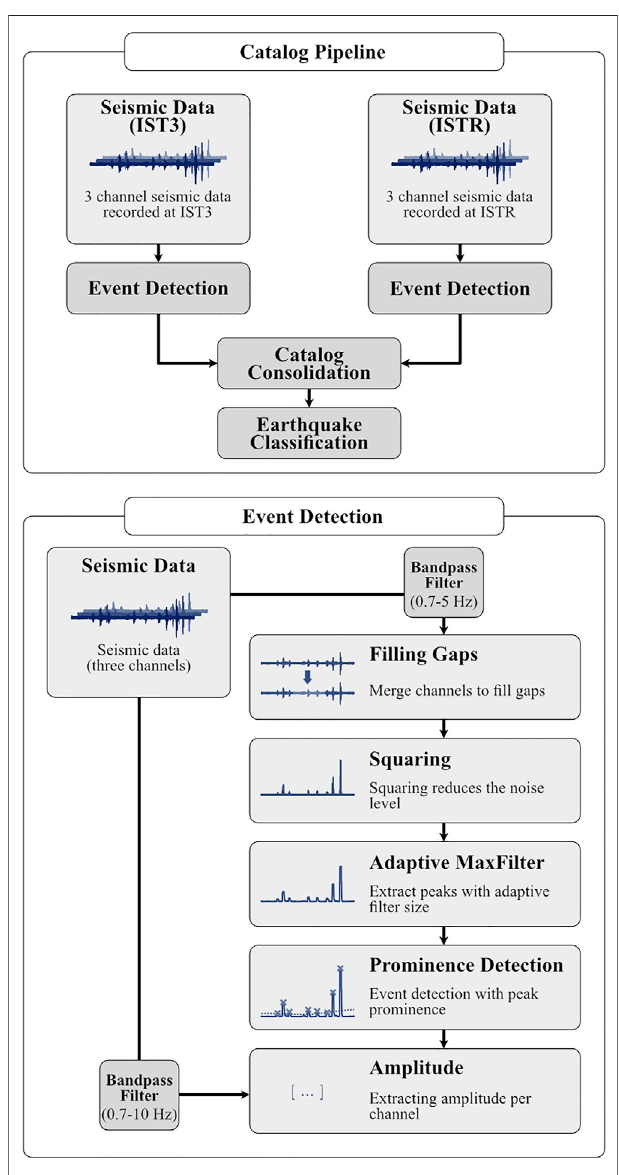
FIGURE 1 | Overview of the catalog creation process using AWESAM including seismo-volcanic event detection, catalog consolidation and earthquake classi fi